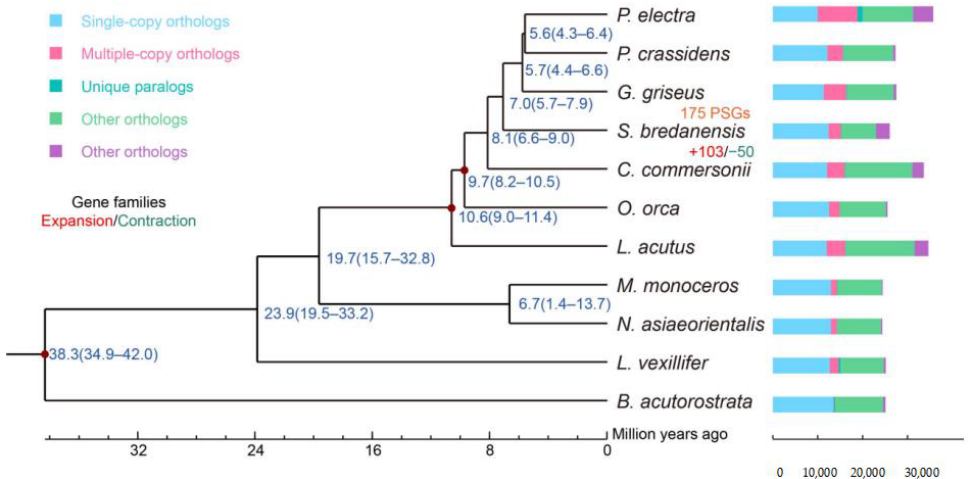
Figure 3. ( Left ) Phylogenetic tree constructed using the maximum likelihood based on 5715 single- copy genes. ( Right ) Gene family clusters among 11 cetaceans.